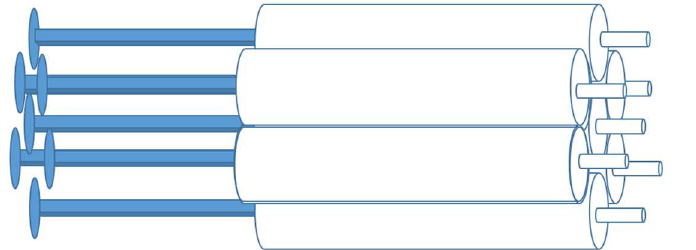
Fig 1. Revolver heterogeneous phantom